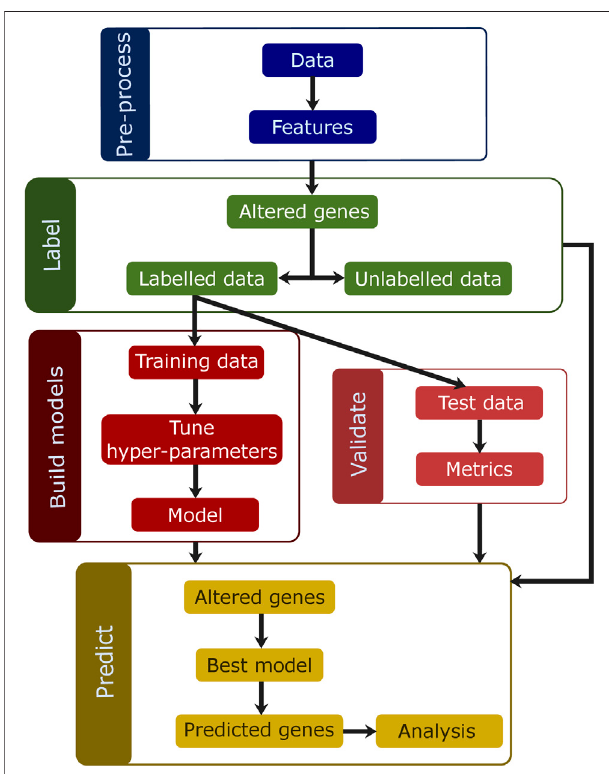
FIGURE 7 | Overview of the methods. The data are preprocessed to generatefeaturestobeusedforclassi fi cation. Thedataarethenlabeledusing oneofthefourlabelingstrategies,andsamplesaresplitintotrainandtest.The training data are used to tune and build models. The metrics are calculated for the predictions made on test data and used to select the best model. The best model is then used to predict TSGs and OGs on the altered genes for all